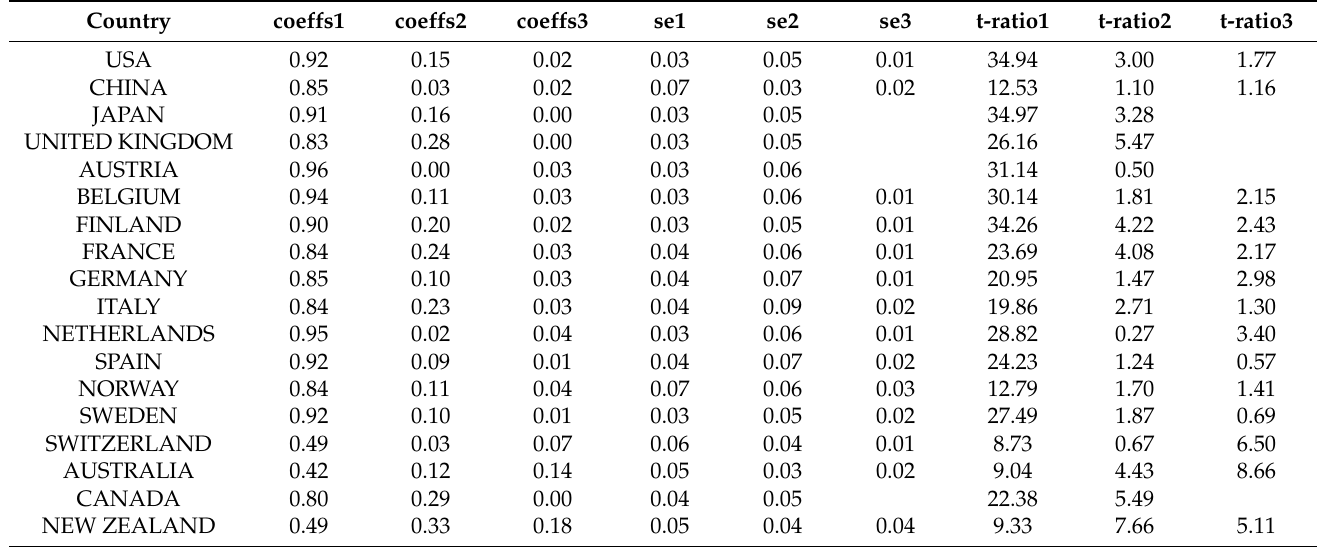
Table A10. Taylor